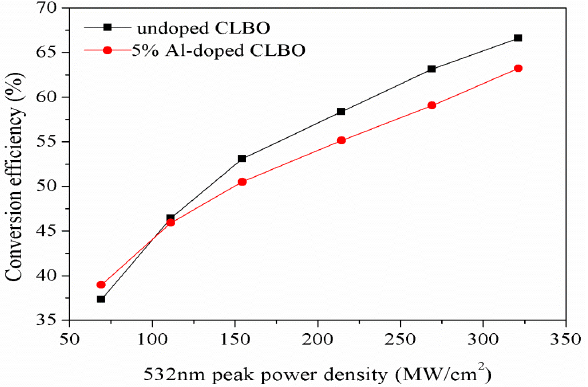
Figure 9. Peak power density dependence at 532 nm of fourth harmonic generation (FHG) conversion efficiency of CLBO crystals.